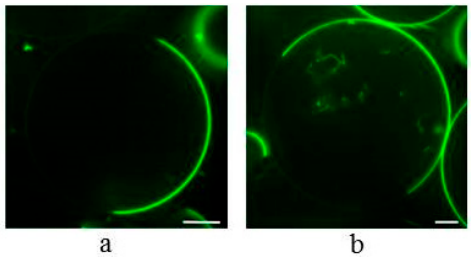
Figure 4. Confocal fluorescence images of Giant Unilamellar Vesicles (GUVs) containing DOPC/SSM/cholesterol (1:1:1) ( a ) or DOPC/SSM/ α -spinasterol (1:1:1) ( b ). The GUV membranes were labeled with N -Rh-DOPE (0.5 mol %) that sorts preferentially into liquid disordered (ld) domains. Bar corresponds to 10 µm.